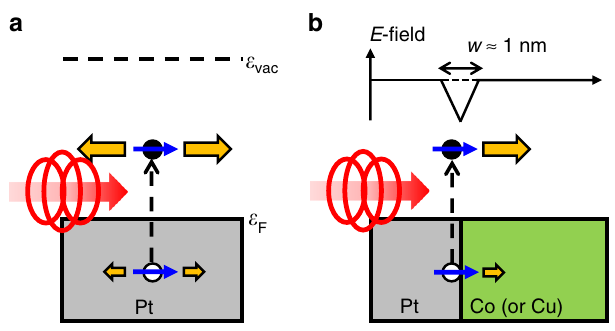
Fig. 5 Mechanisms for spin transport. a The mechanism based on the diffusion of electrons and holes. The optical orientation in Pt induces a spin polarization (blue arrows) on electrons in conduction state ( fi lled circles)/ holes in valence state (empty circles). Both electrons and holes diffuse in all directions. The diffusivity (orange arrows) or diffusion length could be different for electrons and holes. ε and ε represent the Fermi level and F vac vacuum level, respectively. b The mechanism based on the drift of electrons and holes. An electric fi eld ( E - fi eld) develops at the interface with a typical width ( w ) of ≈ 1 nm due to the difference in work functions. The sign of E - fi eld is denoted as negative because the work function of Pt is higher than that of Co or Cu. The E- fi eld induces a directional motion of electrons and holes at the interface. The drift velocity (orange arrows), determined by the summation of the group velocity over k -vectors, could be different for electrons and